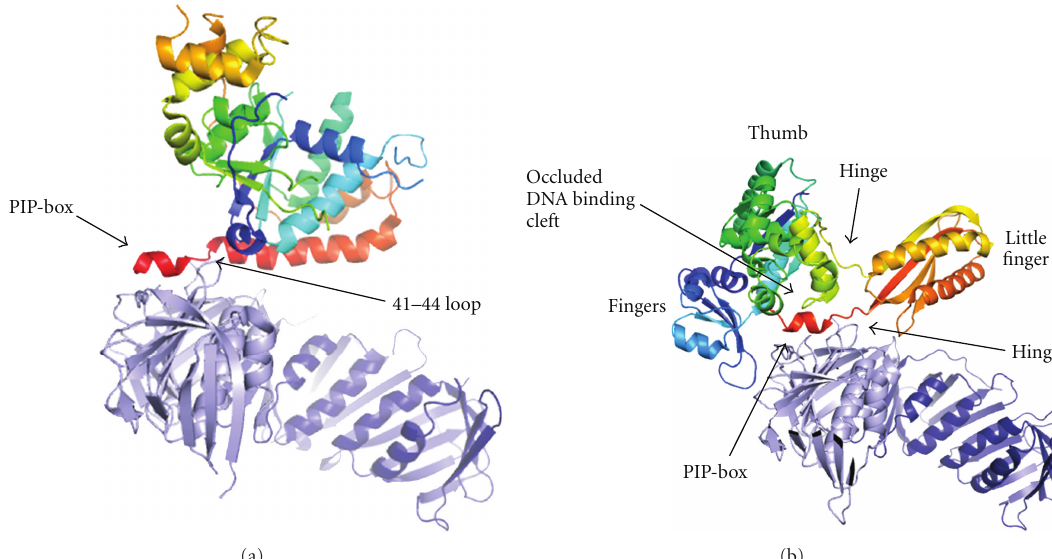
Figure 2: Interactions of the SsoPCNA 1 and 2 heterodimer with (a) Fen1 (2IZO) and (b) Dpo4 (3FDS) [9, 10]. The PCNA subunits are coloured light (PCNA1) and dark (PCNA2) blue. The principal PIP-box interaction is indicated, as are other key interacting domains.